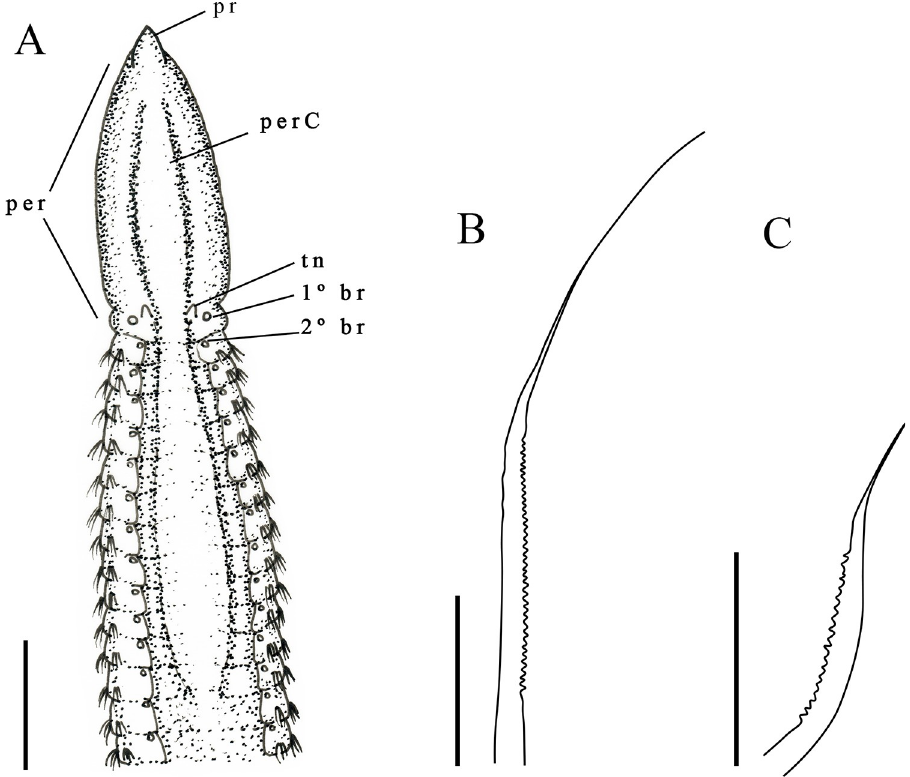
Fig 5. Kirkegaardia goytaca sp. nov. (A) anterior end, dorsal view; (B) notopodial capillary denticulated; (C) neuropodial capillary denticulated. A–C (MNRJP-002990). Scale bars; 200 μ m (A-C). Type locality. Atlantic Ocean: Campos Basin (Brazil). Habitat. Fine sediments (clay) and sandy sediments organically enriched, 21 and 43 m depth. Distribution. Presently known only from Atlantic Ocean: Campos Basin (Brazil). Methyl Green. No pattern, stain not